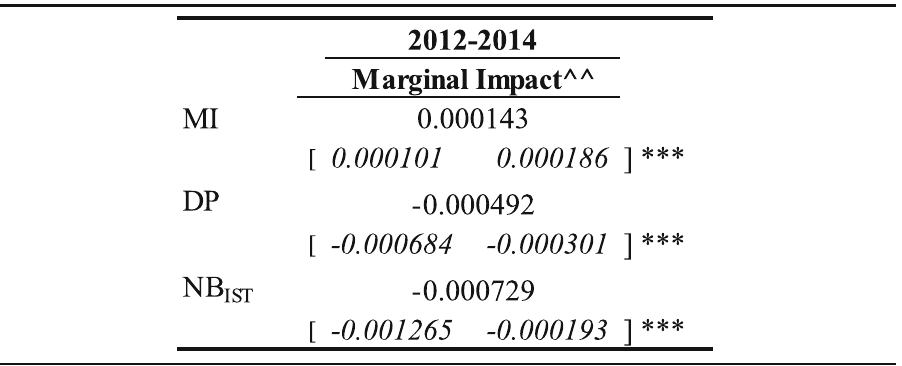
Table 9 Gini decomposition. Marginal Impact by income source derived from the bootstrap procedure in the whole period 2012 –